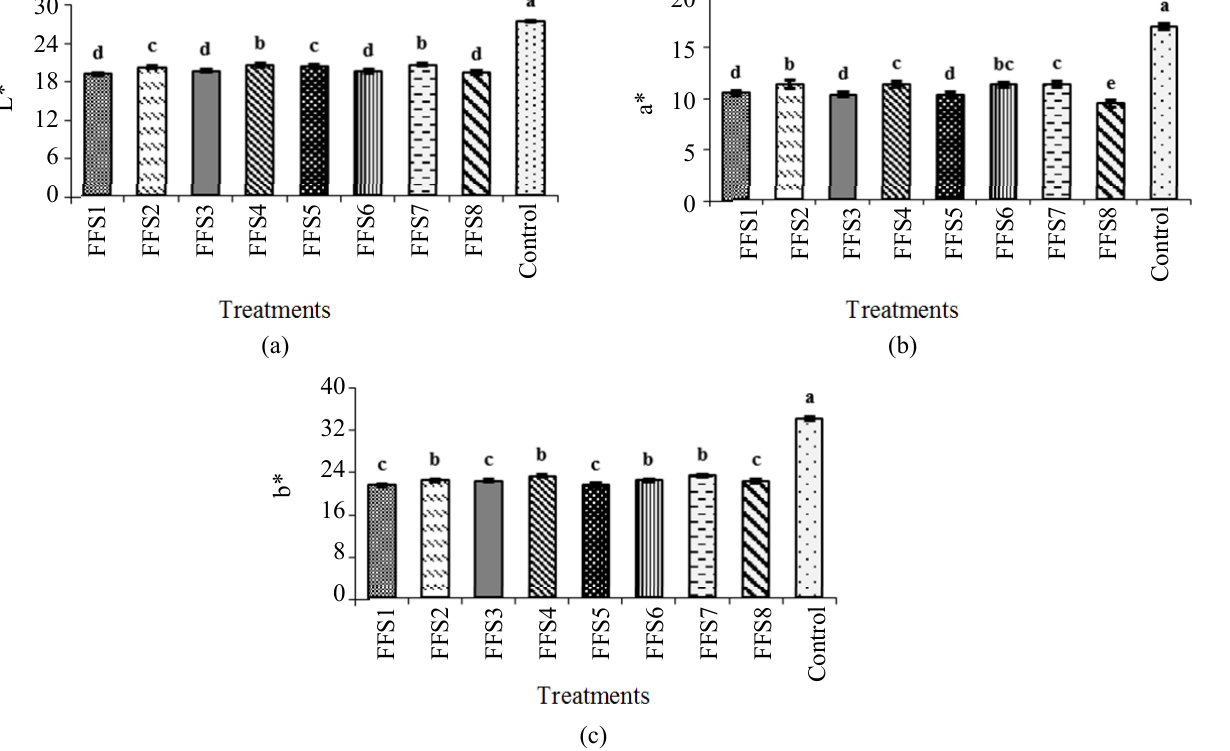
Fig. 5. Color properties of the fortified Vietnamese tamarind fish sauces.